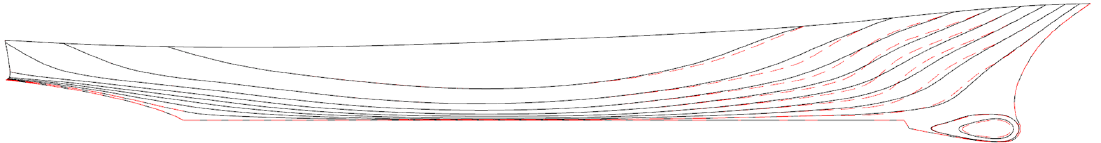
Figure 21. Comparison of body plan views of dimensionality reduction optimized and original hull forms.